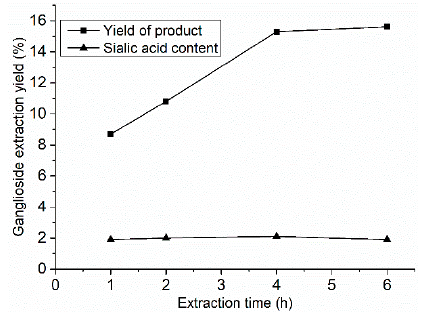
Figure 1. Ganglioside extraction kinetics of SCE .